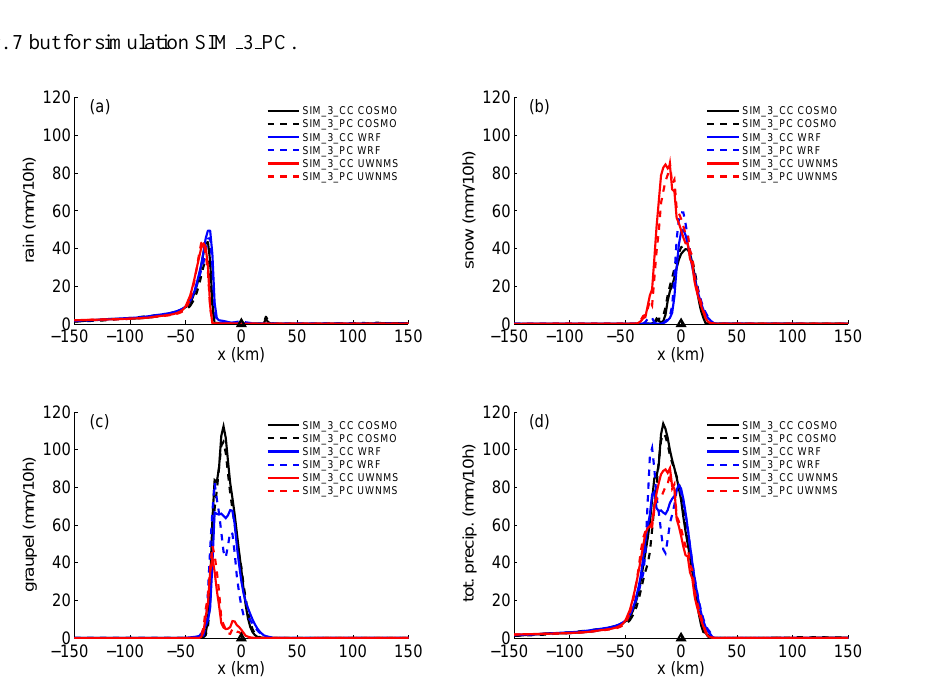
Fig. 17. Same as Fig. 9 but for simulation SIM 3 CC (solid) and SIM 3 PC (dashed). important for cloud formation. All models develop a blocked air layer on the upstream side of the mountain with a depth of approximately 2800 m. In this layer the horizontal wind speeds are decelerated to roughly 10 m s − 1 . The UWNMS model develops slightly stronger blocking than COSMO and WRF with a stagnant air layer at low levels and even slight reverse circulations. These differences may be attributable to differences in the numerics of the model or the VST coordi- nate system used in